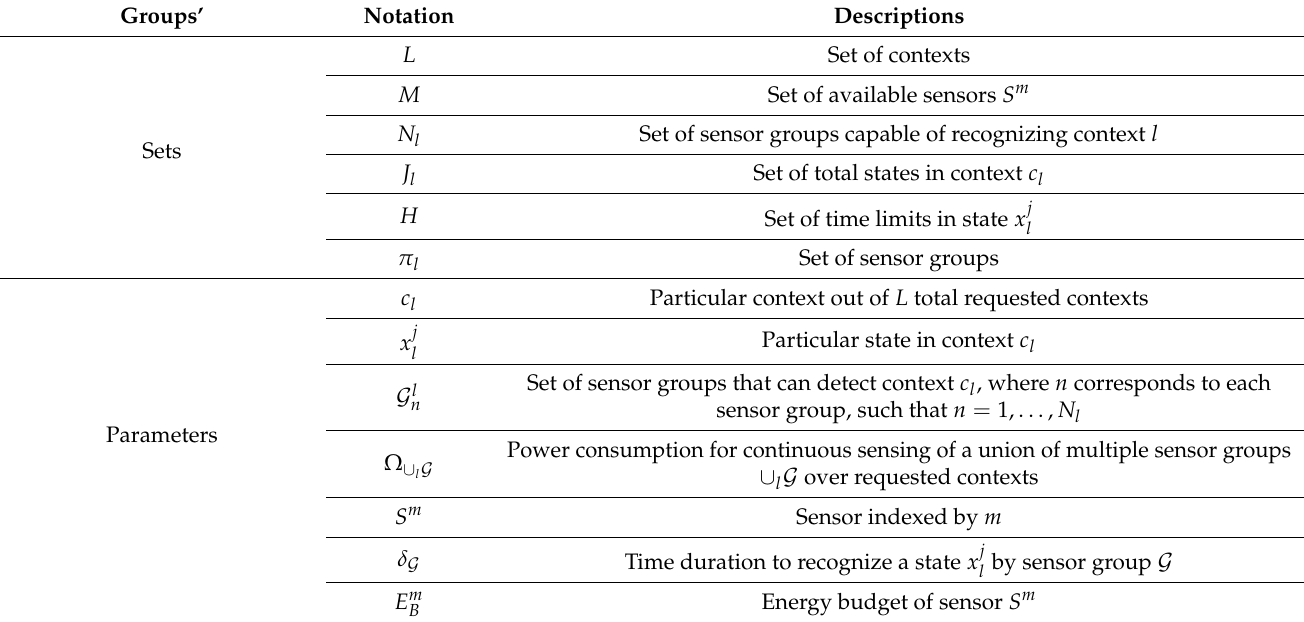
Table A1. Table of